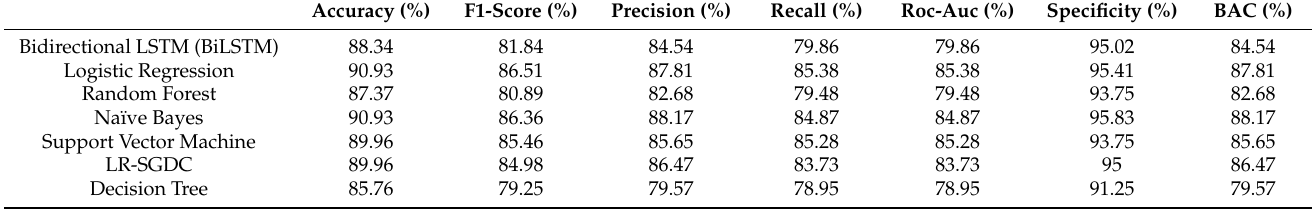
Table 7. The performance measure of various classifiers of the second dataset.